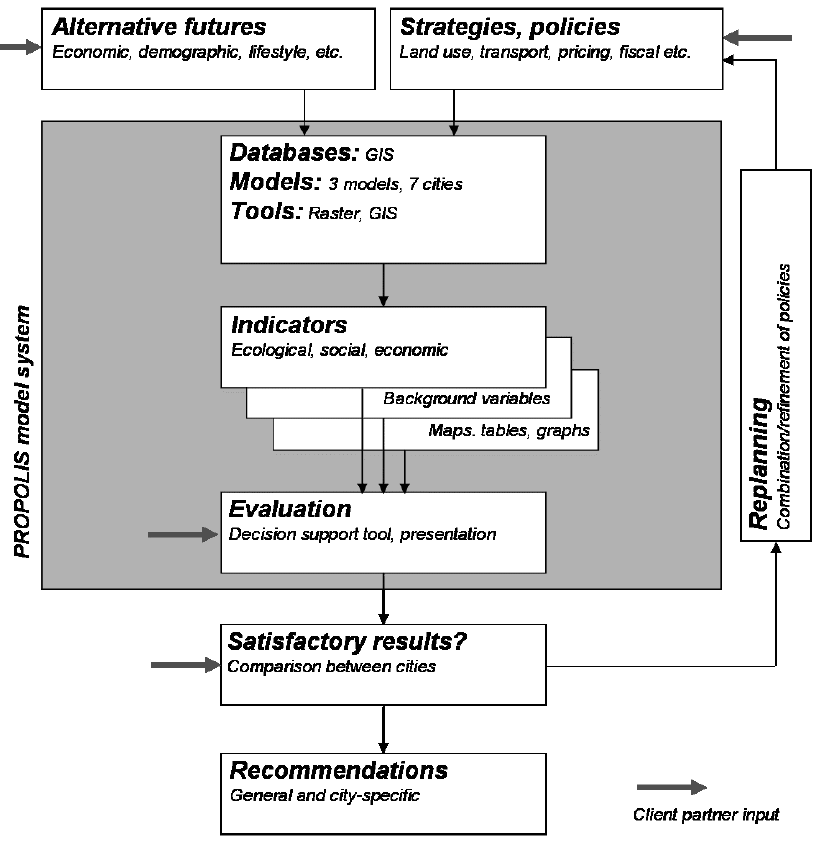
Figure 2. Policy testing